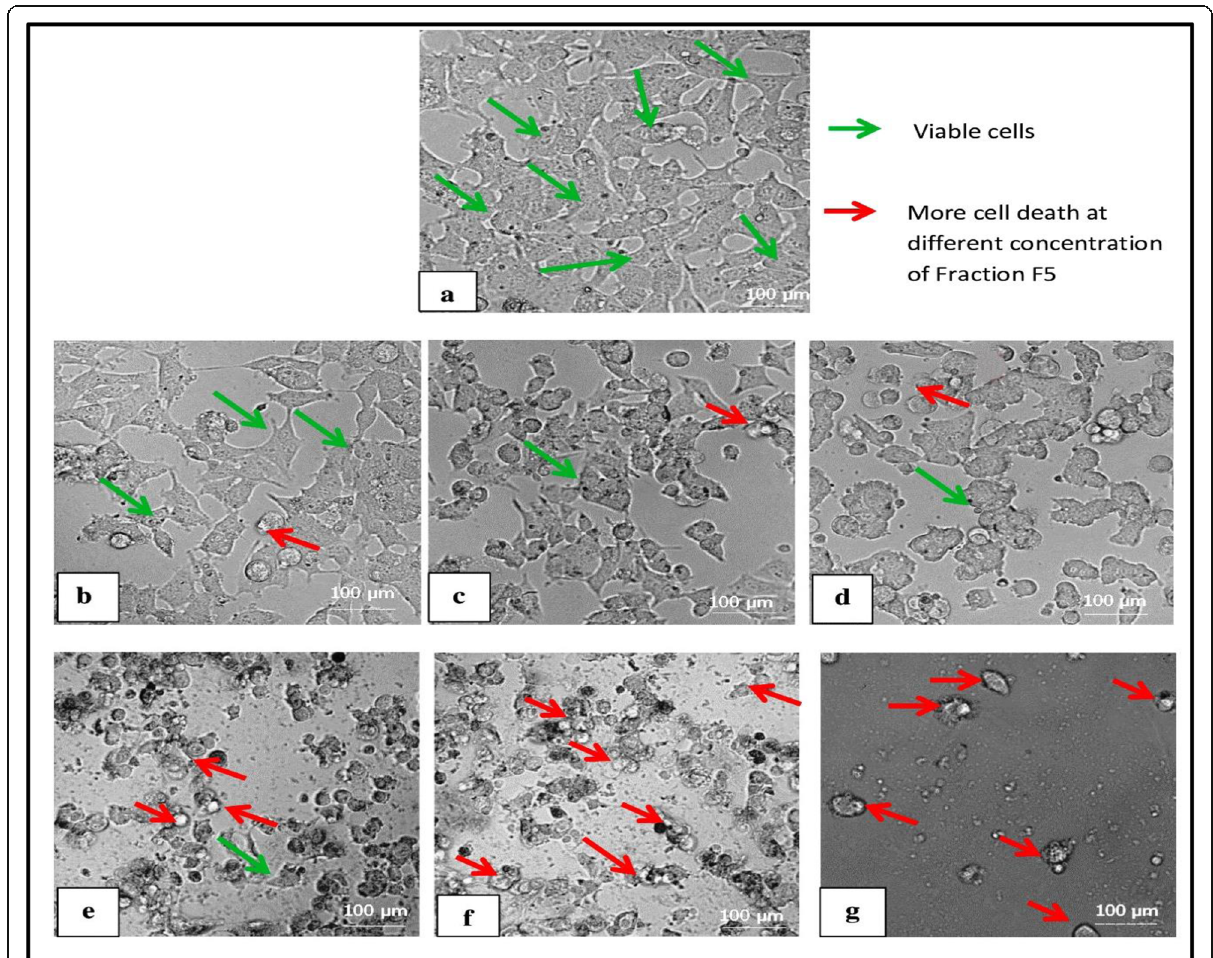
Fig. 3 Morphological profile of the MCF-7 after treated with fraction 5(F5) of ethyl acetate extract of Clerodendrum thomsoniae Balf.f. 1.0 μ